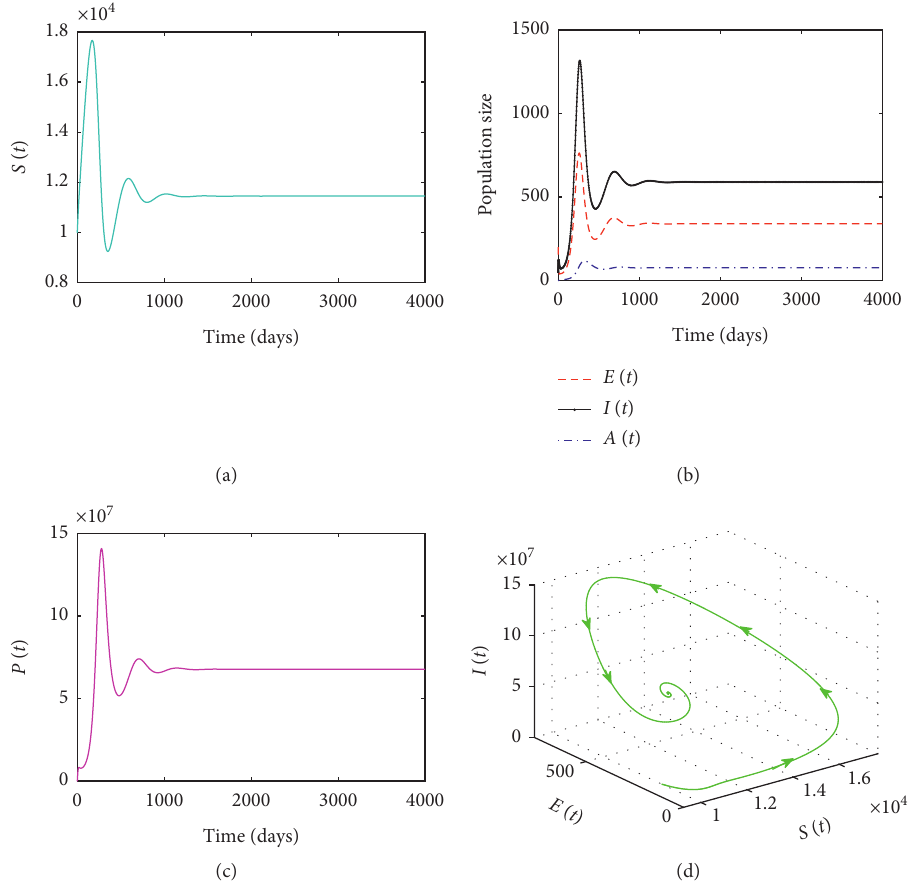
Figure 6: Numerical results of system (1) depicting the persistence of the disease of R Parameter values used to construct the simulations are in Table 1, with p � 0 . 01, κ � ϵ � 1 . 05, and f � 0 . 01, leading to R